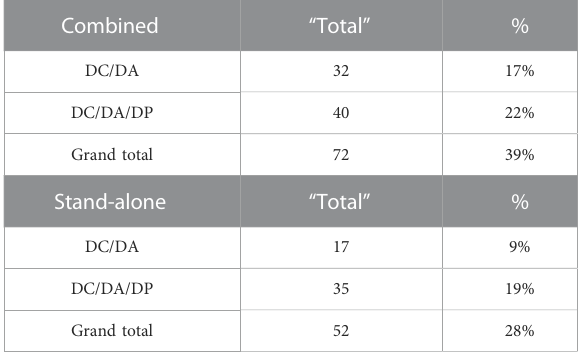
TABLE 7 Data stages distribution between combined and stand-alone technologies.